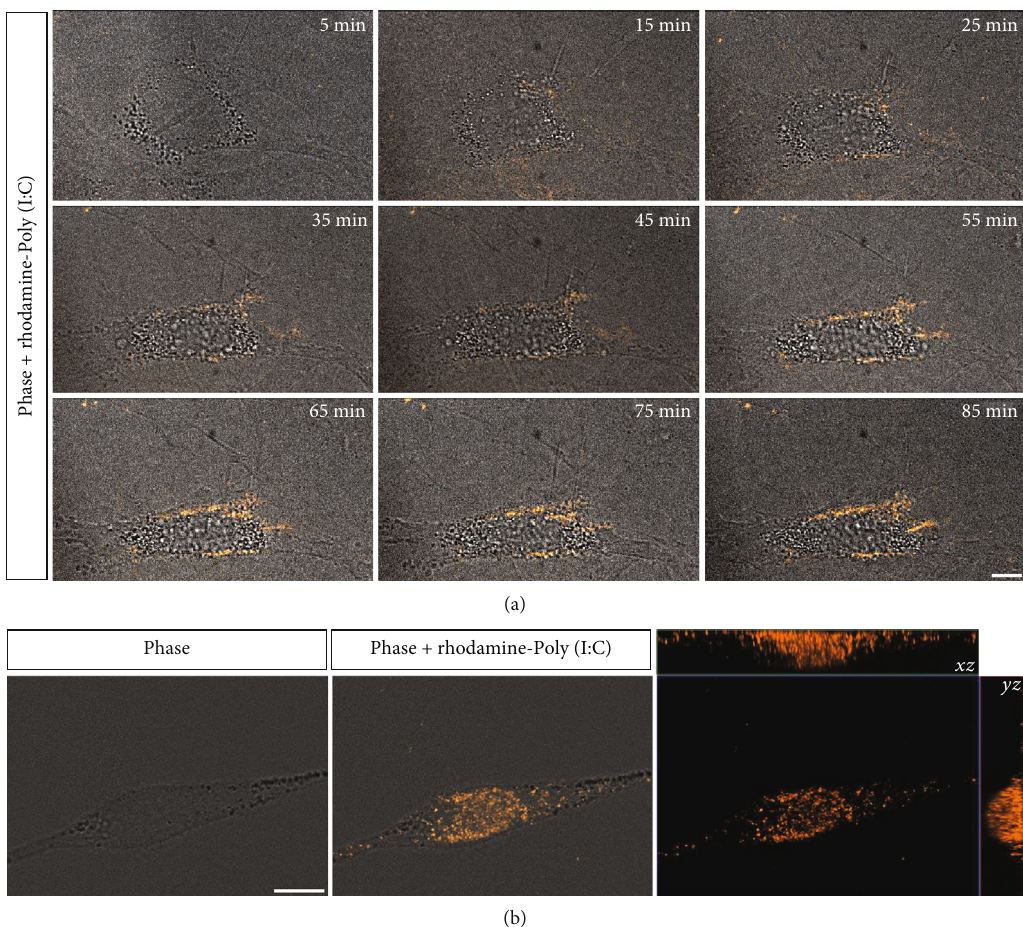
Figure 1: Internalization of rhodamine-conjugated polyinosinic-polycytidylic acid (Poly(I:C)) by rBM-MSCs. (a) Representative photomicrographs from time-lapse video microscopy, each corresponding to the indicated time points following the addition of rhodamine-conjugated Poly(I:C) to the culture medium, showing the overlay of phase contrast and spinning disk confocal fl uorescence images of one cell (rhodamine-conjugated Poly(I:C) is shown in red). Scale bar: 10 μ m. (b) On the left, phase contrast image of a cell at 1h after incubation with rhodamine-conjugated Poly(I:C). On the center, overlay of the phase contrast image and the maximum intensity projection of a z stack showing rhodamine-conjugated Poly(I:C) in red. On the right, orthogonal projections (XZ, YZ) of the z stack showing the internalization of rhodamine-conjugated Poly(I:C) (in red) by this cell. Scale bar: 10 μ